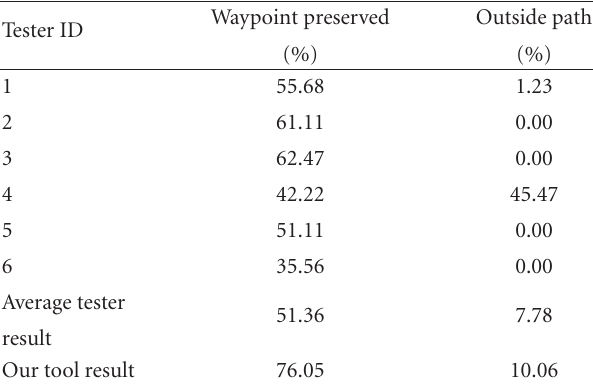
Table 2: Tuning accuracy results from testers and the tool. Tester